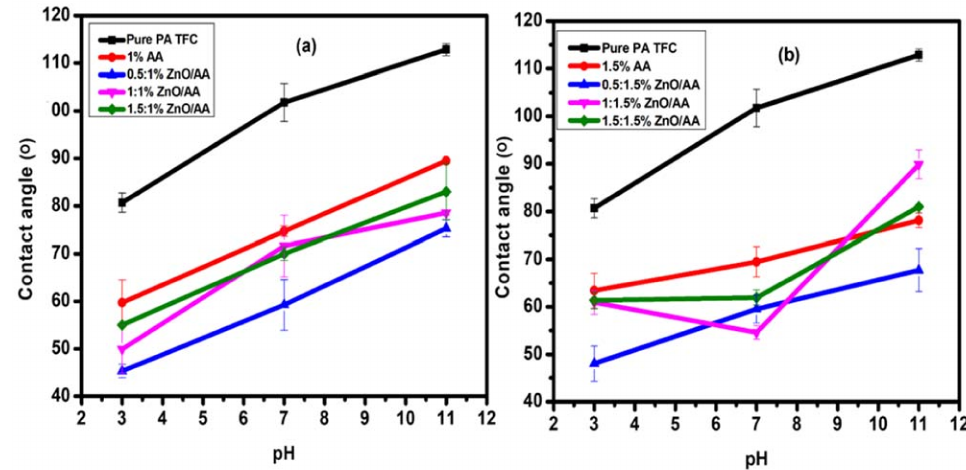
Figure 7. Contact angle analysis of: ( a ) membranes modified with 0.00% ZnO/AA, 1.00% AA, 0.50:1.00% ZnO/AA, 1.00:1.00% ZnO/AA, and 1.50:1.00% ZnO/AA; and: ( b ) membranes modified with 1.50% AA, 0.50:1.50% ZnO/AA, 1.00:1.50% ZnO/AA, and 1.50:1.50%